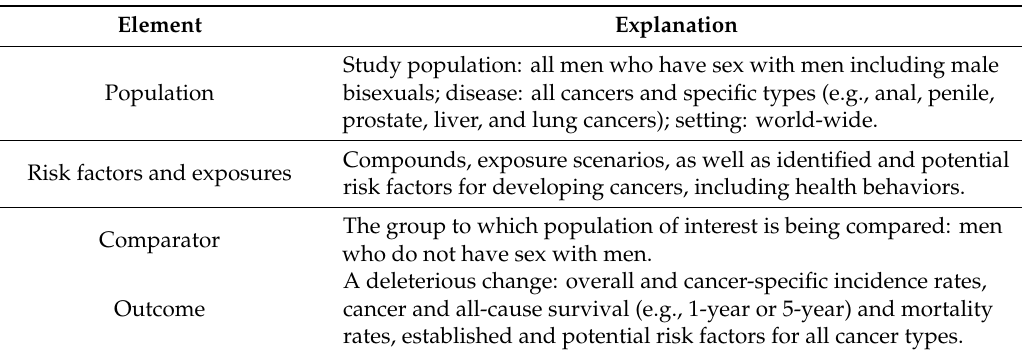
Table 2. Adapted PECO (Populations, Exposure, Comparator, and Outcomes) Framework for Developing the Key Questions Examined in the Umbrella Review on Cancers among Men having Sex with Men (MSM) [31].